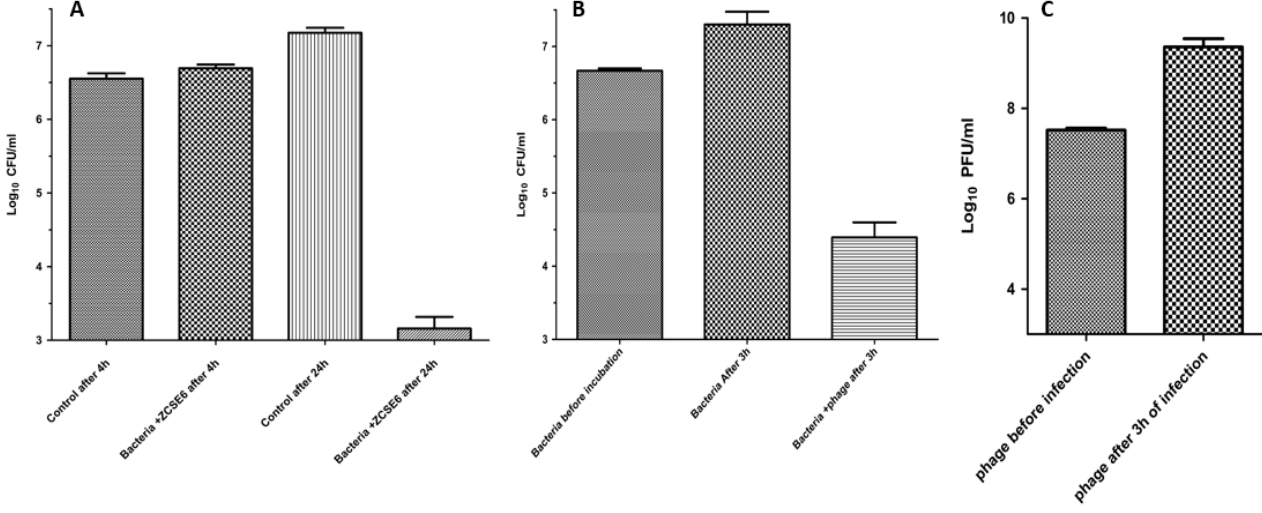
Figure 3. illustrates ( A ) the bacterial survival at low-temperature 8 °C in media after 4 and 24 h; ( B ) Bacterial reduction in milk at 37 °C after 3 h of phage treatment; and ( C ) the phage propagation in milk containing Salmonella bacteria after 3 h of incubation at 37 °C.